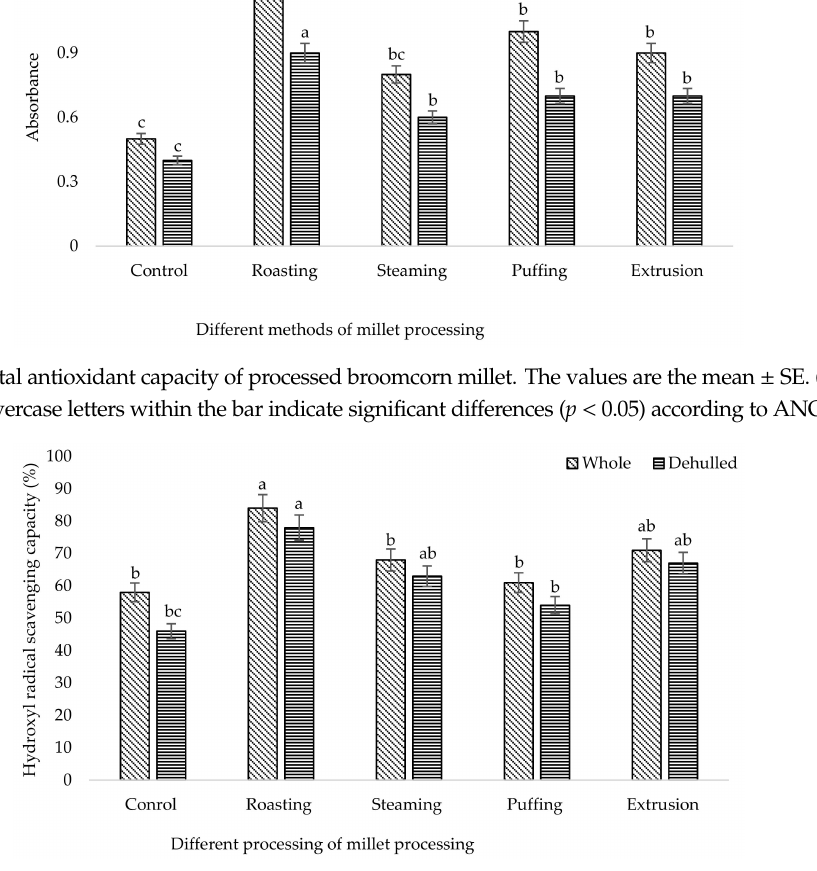
Figure 4. Hydroxyl radical scavenging capacity of processed broomcorn millet. The values are the mean ± SE. ( n = 3). Di ff erent lowercase letters within the bar indicate significant di ff erences ( p < 0.05) according to